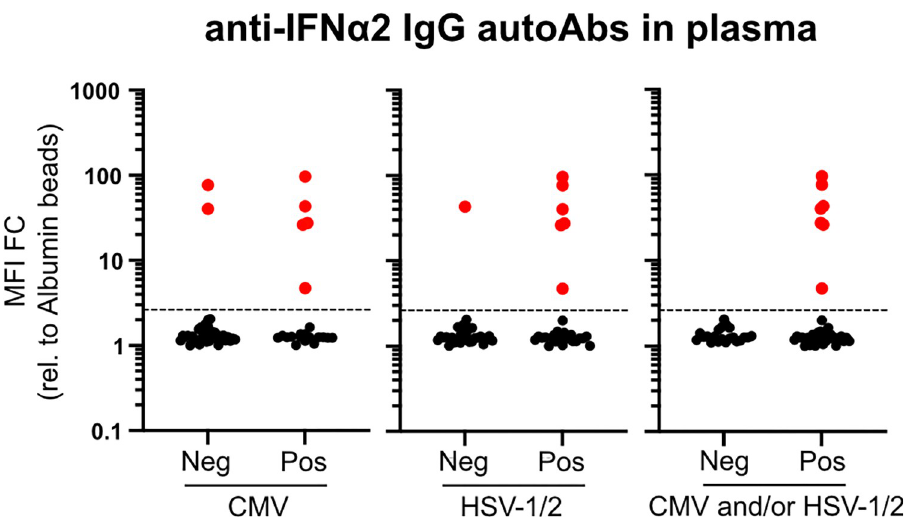
Fig 3. Presence of autoantibodies targeting type I IFNs as a predictor of herpesvirus disease in critically ill COVID-19 patients. Fifty-nine severe COVID-19 patients in ICU were tested for herpesvirus (HSV-1/2 and CMV) reactivations in their blood by PCR. Pos (positivity) and Neg (negativity) for CMV, HSV-1/2, and CMV and/or HSV- 1/2 were used to stratify the results obtained when plasma samples from the same patient were assayed for IgG autoAbs targeting IFN α 2 (see Fig 1). MFI FC of signal derived from IFN α 2-coated beads relative to the MFI of signal derived from albumin-coated beads is shown for each individual patient. Values above the dashed line are considered positive (red). Data underlying this figure can be found in S1 Data. autoAbs, autoantibodies; CMV, cytomegalovirus; COVID- 19, Coronavirus Disease 2019; FC, fold change; MFI, median fluorescence intensity; HSV-1/2, herpes simplex virus types 1 or 2; ICU, intensive care unit; IFN,